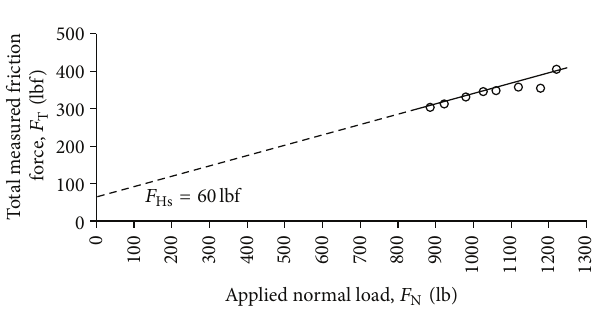
Figure 17: Wet Tyrone Boulevard test results.